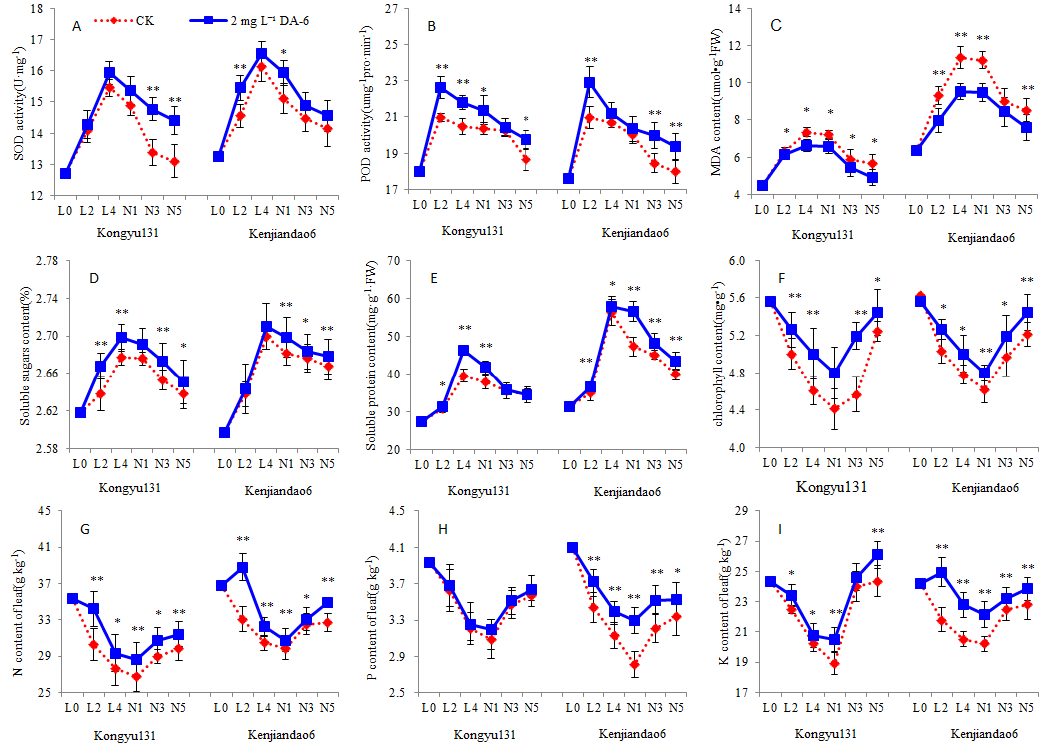
Figure 7. Effects of diethylaminoethyl hexanoate (DA-6) treatment on the activities of ( A ) superoxide dismutase (SOD) and ( B ) peroxidase (POD), and on ( C ) alondialdehyde (MDA), ( D ) soluble sugars, ( E ) soluble protein, ( F ) chlorophyll, ( G ) nitrogen (N), ( H ) phosphorus (P), and ( I ) potassium (K) contents in both cultivars under cold water stress (CWS) at booting. L0, L2, and L4 indicate before day 1, on the second day, and on the fourth day of the cold water stress (CWS), respectively. N1, N3, and N5 indicate the first, third, and fifth days after recovery to normal temperature, respectively. **, p > 0.01; *, p >